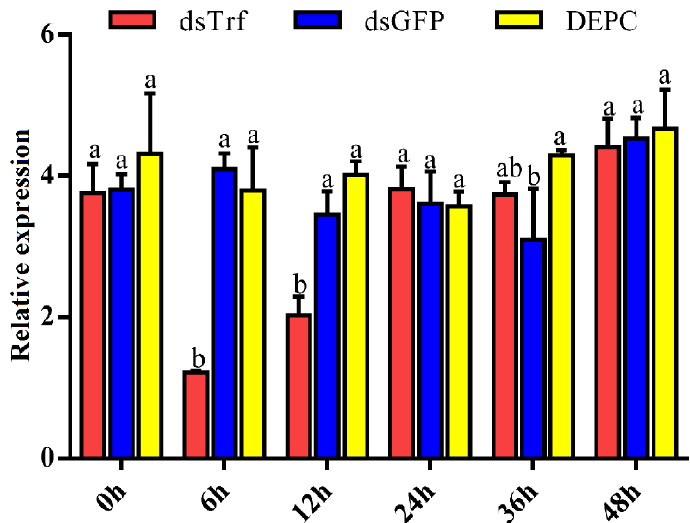
Figure 4. Analyses of the PxTrf expression of dsRNA-reated P. xylostella using RT-qPCR. dsTrf: injection double-stranded PxTrf (dsPxTrf). dsGFP: injection dsGFP. DEPC: injection DEPC-treated water. Data